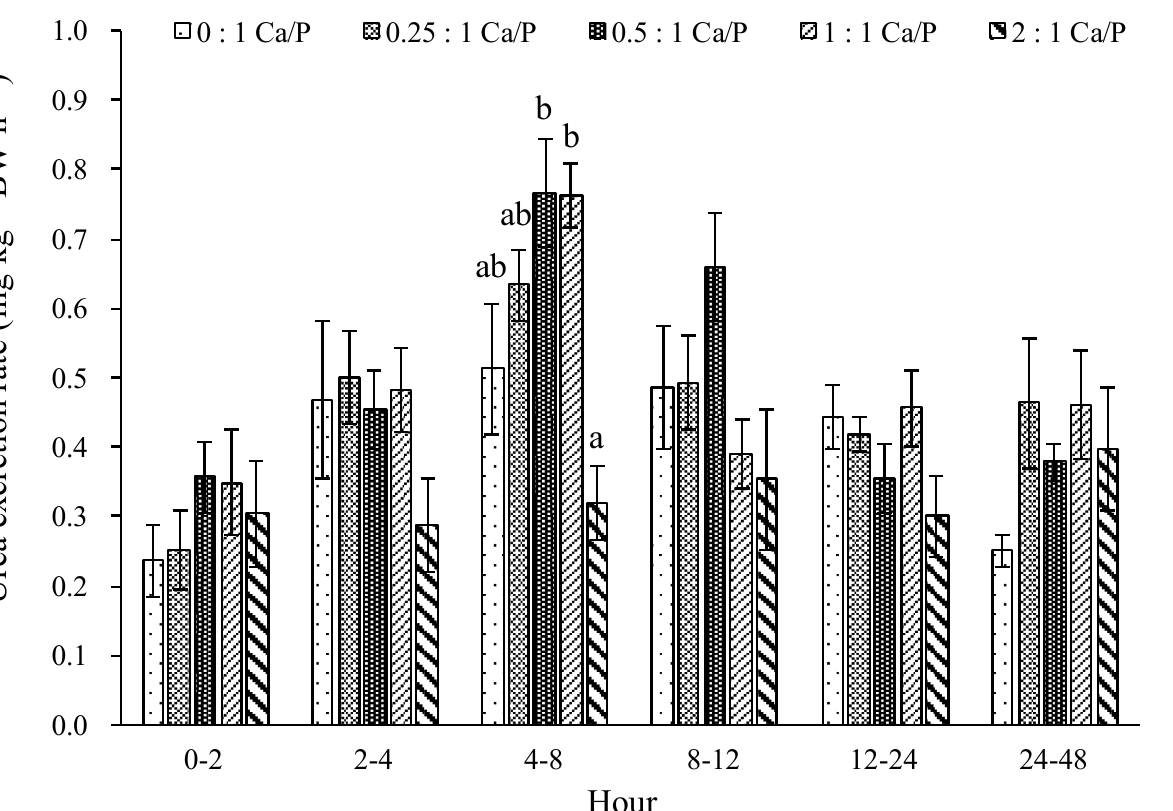
Figure 4. Urea excretion rate of hybrid sturgeon ( Huso dauricus ♀ X Acipenser schrenckii ♂ ) after being intubated with 100 mg P·kg − 1 BW at different Ca/P ratios. Different letters indicate significant differences among the treatments for each sampling time ( p < 0.05).